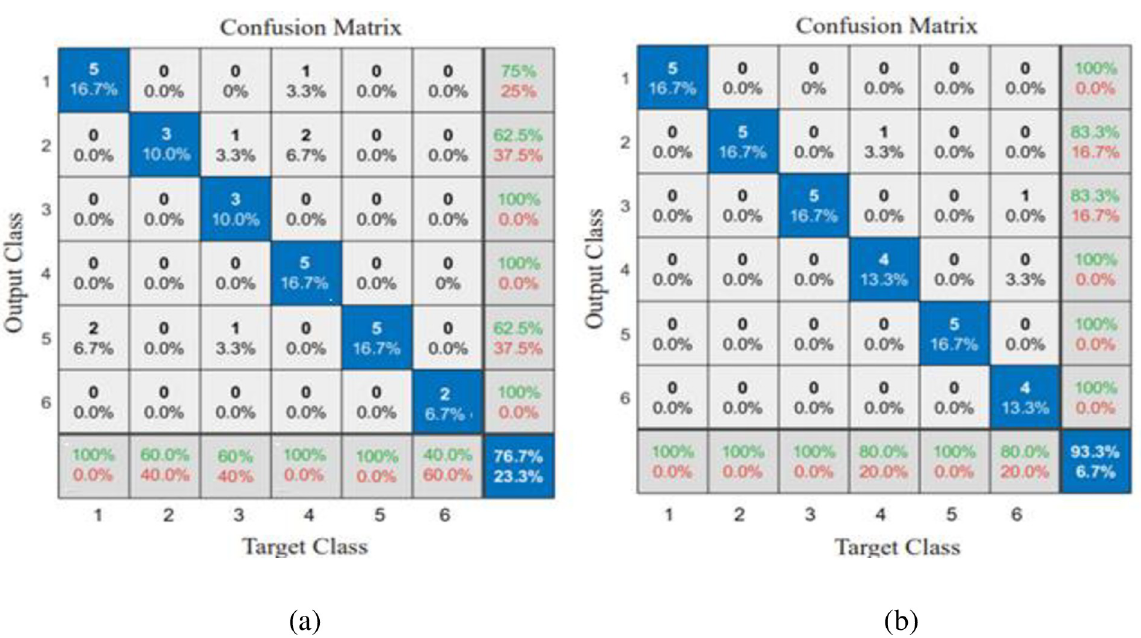
PLOS ONE | https://doi.org/10.1371/journal.pone.0284021 April 5, 2023 19 /